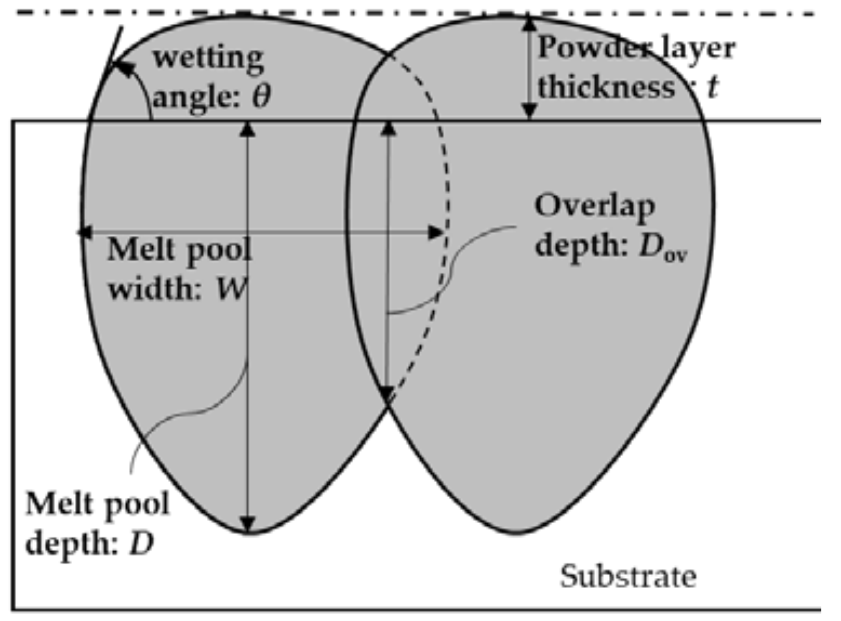
Figure 1. A schematic of the extended Eager–Tsai (E-T) model for the multi-scans in the L-PBF process. The overlap depth ( D ov ) is the depth of overlap area between the first and the second laser